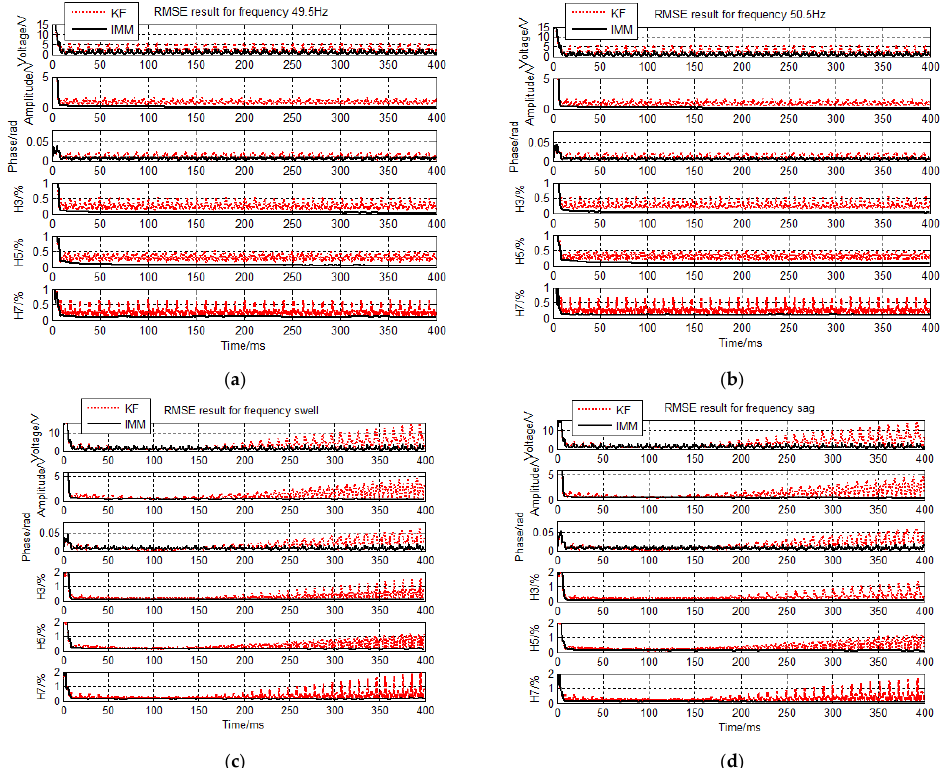
Figure 9. Simulation RMSE results for voltage frequency heavy fluctuations. ( a ) Simulation RMSE results for frequency 49.5 Hz; ( b ) Simulation RMSE results for frequency 50.5 Hz; ( c ) Simulation RMSE results for frequency swell; ( d ) Simulation RMSE results for frequency sag.